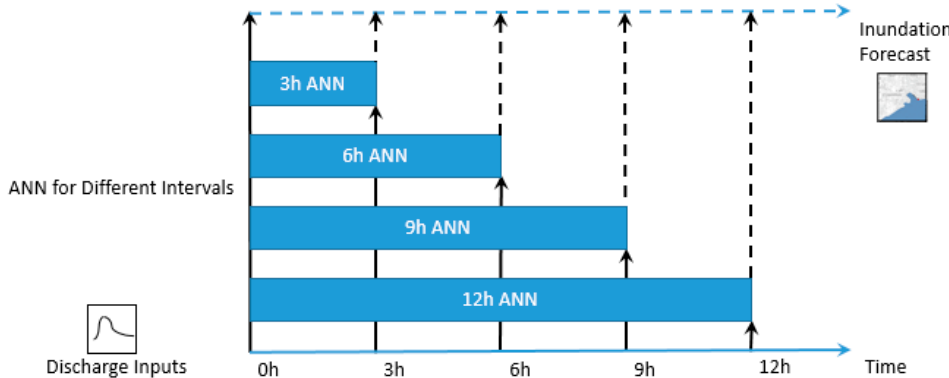
Figure 2. Training of artificial neural networks (ANN) forecast model. Four ANN models for 3 h, 6 h, 9 h, 12 h first interval predictions are set up in this work, trained with the discharges from each synthetic flood event. After this, the models are to predict the corresponding first intervals for other